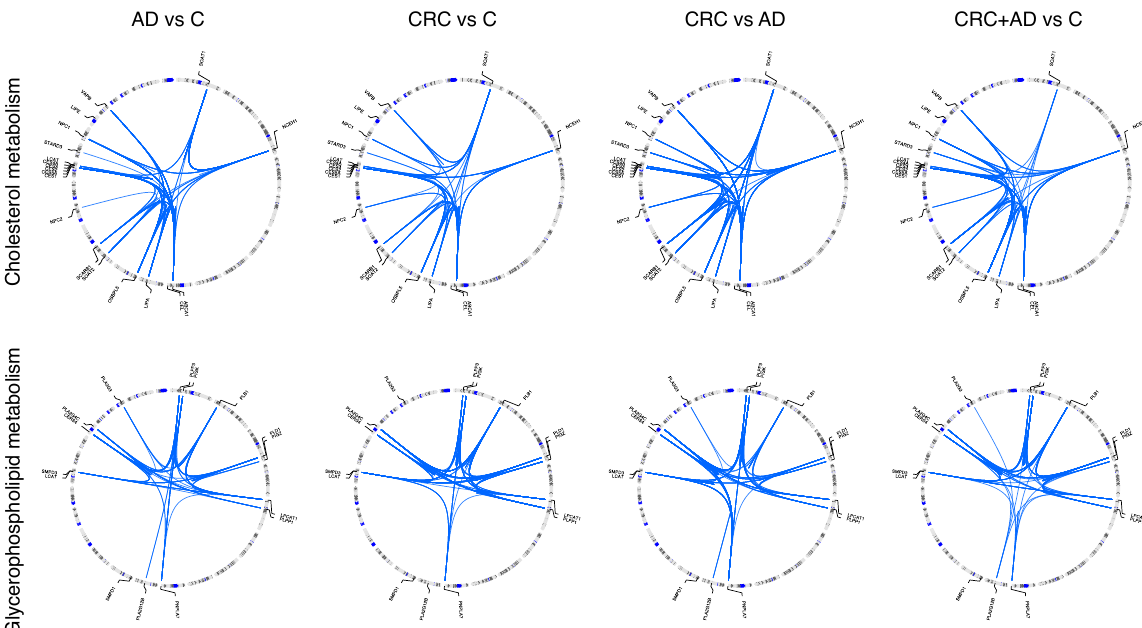
Figure 1. Epistatic interaction between SNPs of genes of cholesterol esters metabolism and Glycerophospholipid, Sphin- golipid metabolism, Glycosylphosphatidylinositol(GPI)-anchor biosynthesis